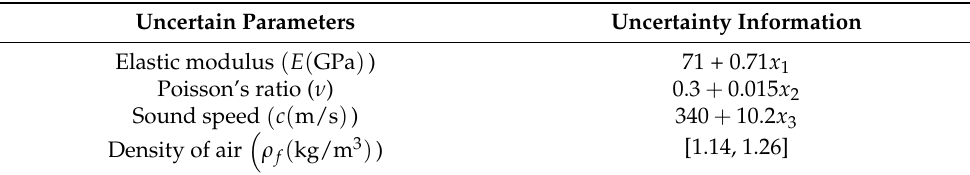
Table 5. Uncertain parameters of uncertain shell structural-acoustic systems.